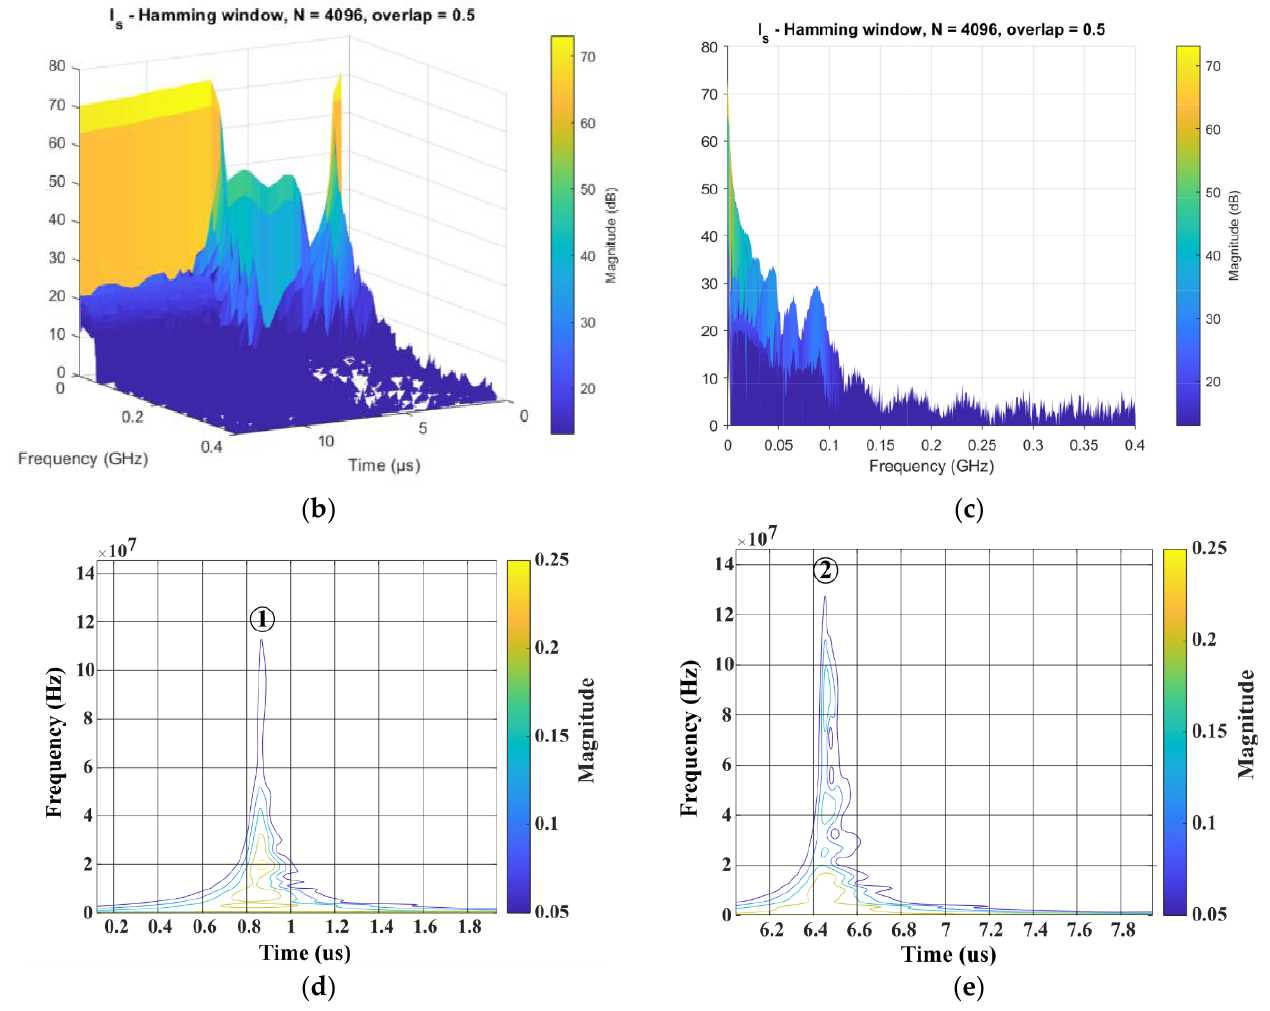
Figure 10. Event detection and discrimination using STFT and wavelet: ( a ) time signal I_s; ( b ) time – frequency – magnitude representation of the STFT; ( c ) frequency – magnitude representation of the STFT; ( d ) detail of the wavelet transform in the interval 0- 2 μs using Morse wavelet; ( e ) detail of the wavelet transform in the interval 6–8 µ s using Morse